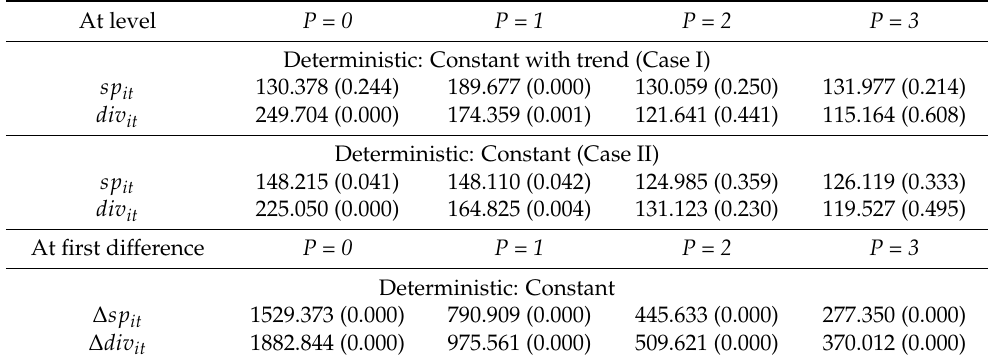
Table 3. Maddala and Wu (1999) Panel Unit Root test